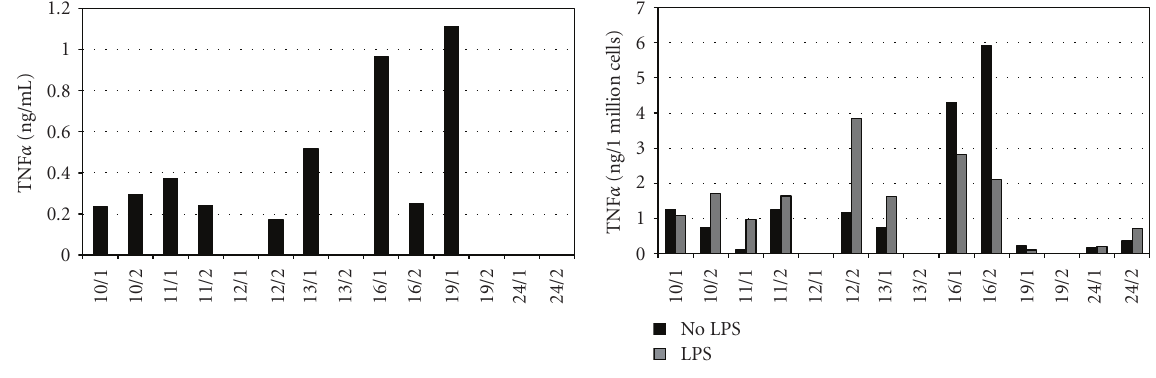
Figure 5: Female volunteers also demonstrate high interindividual di ff erences both in circulating TNF α and inducibility of PBMCs during menstrual cycle. Interestingly, volunteer 16 demonstrates the highest TNF α values, and endotoxin tolerance can be observed as a part of the autoregulatory system protecting against extremely high TNF